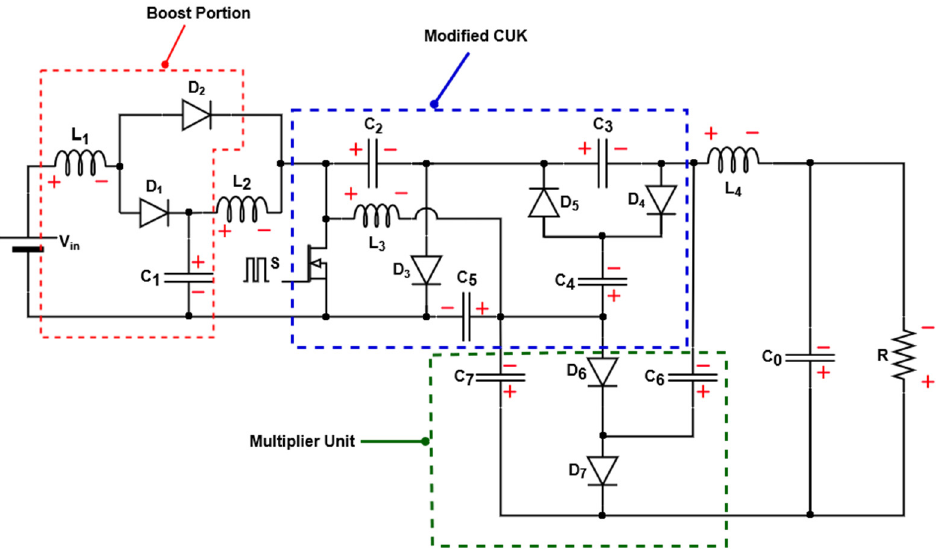
Figure 1. Modified high-gain CUK-based converter with multiple voltage multipliers.